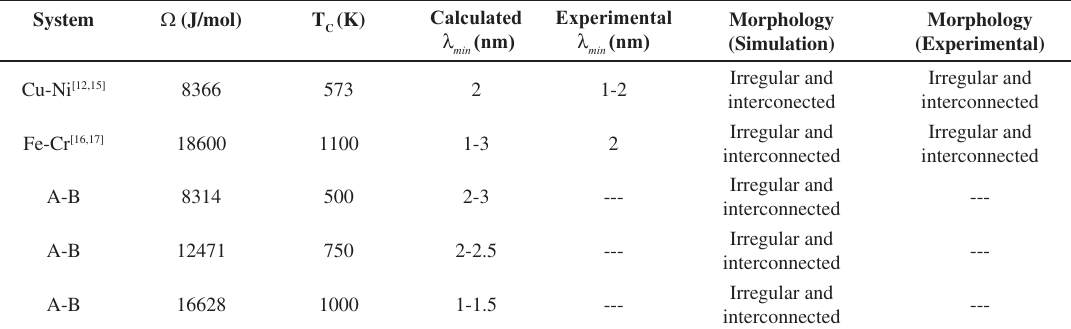
Table 2. Comparison of present work simulated results with other works.